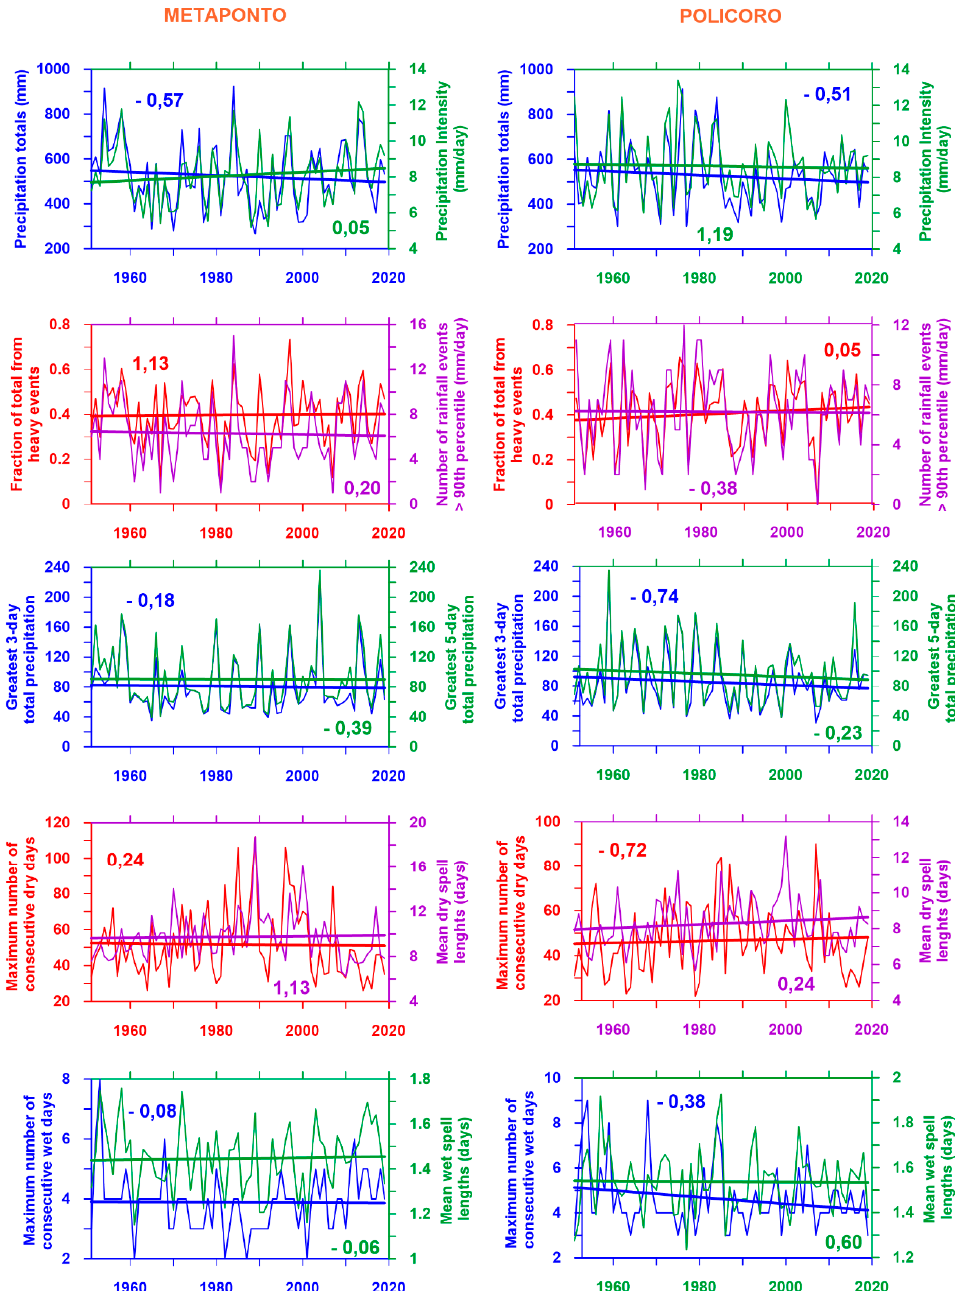
Figure 6. Pluviometric indices of Metaponto and Policoro rain gauges, 1951–2019. Bold colored numbers indicate the Z-value of the Mann–Kendall statistic. None of the trends is statistically